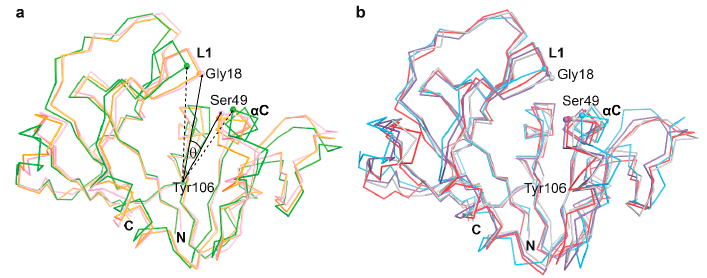
Figure 4. Overall structural comparison of mtbDHFR. ( a ) Superposition of the binary mtbDHFR:NADPH crystal structures in closed (4KL9 in pink and 1DG8 in orange) and open (4KLX in green) conformation states. The angle θ is measured from the angle between three alpha-C atoms (ball models) of Ser49, Tyr106, and Gly18; ( b ) Superposition of the ternary mtbDHFR:NADPH:2,4-diaminopyrimidine complex from MD simulations at 16 ns: P1 (blue), P157 (purple), P169 (red), and DHF (gray).